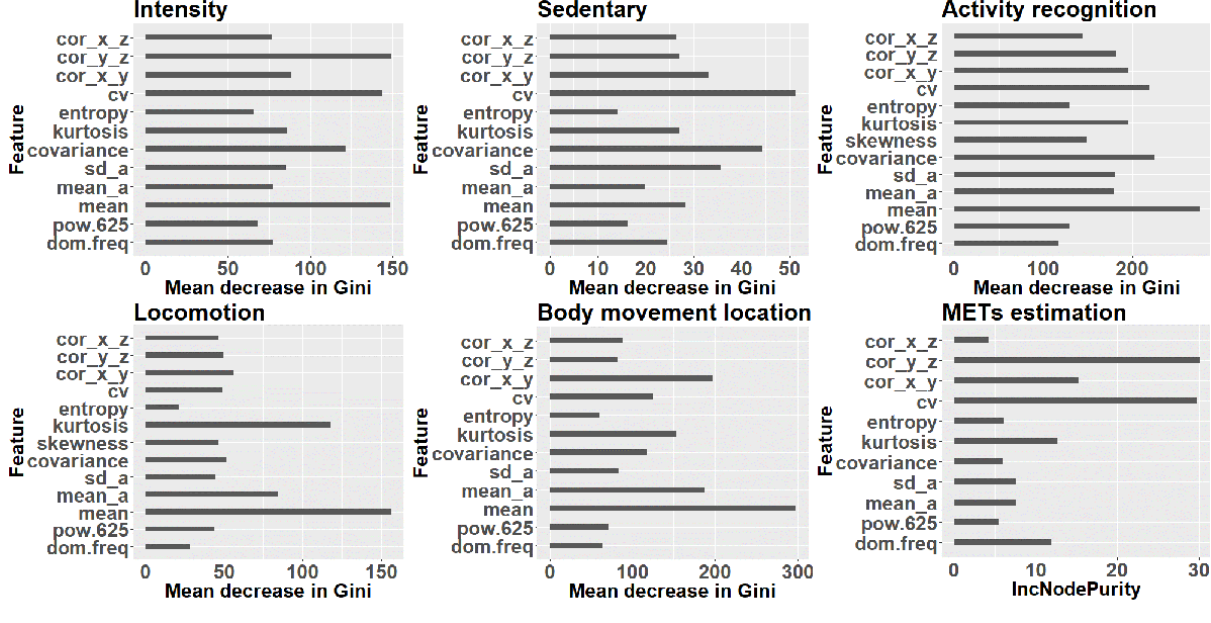
Figure 12. Importance of features in terms of the mean decrease in the Gini index in each classification task and in terms of the increase in node purity for the metabolic equivalent scores estimation regression task, as reported by the random forest model and 16-second window length for feature extraction (note the different range for the x-axis). METs: metabolic equivalent scores; IncNodePurity: Increase in node purity; cor_x_z: correlation between x-axis and z-axis; cor_y_z: correlation between y-axis and z-axis; cor_x_y: correlation between x-axis and y-axis; cv: covariance of the vector magnitude; sd_a: SD of angle; mean_a: mean of angle; pow.625: percentage of the power of the vector magnitude that is in the range of 0.6-2.5 Hz; dom.freq: dominant frequency of vector